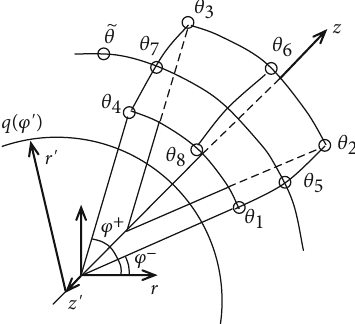
Figure 2: Layout of the boundary condition formation